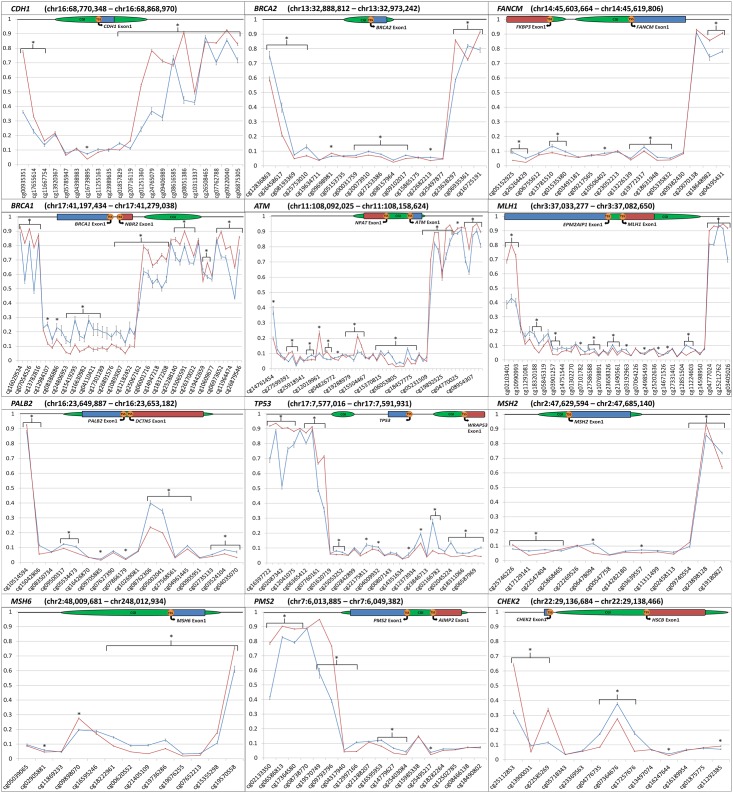
Comparison of average blood and tumor-derived DNA methylation across a panel of tumor suppressor genes.Plotted β-values at CpG probes across defined genomic regions. Red line indicates average β-value for blood-derived DNA samples. Blue line indicates average β-values for tumor-derived DNA samples. * indicates significant statistical difference (p<0.01). Error bars are plotted Standard Error of Mean. Gene region schematics denote [CGI (CpG Island), TSS (Transcriptional Start Site)].